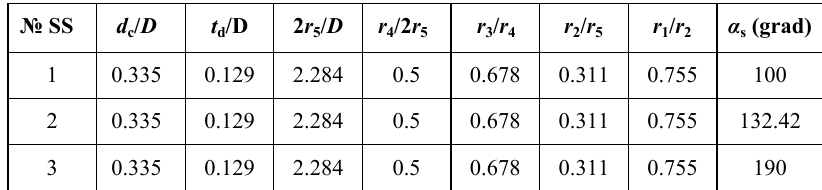
Table 1. Dimensions of SS